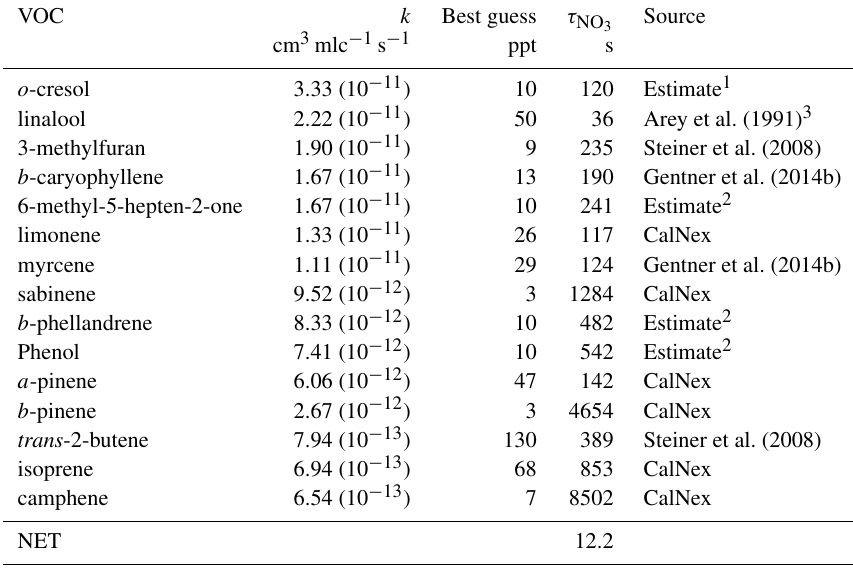
Table 2. Estimations of VOC reactions with nitrate in the summertime nocturnal boundary layer for the SSJV. Reaction rates from Atkinson and Arey (1998), Table 2, and Atkinson et al. (2006). Source VOC k Best guess τ NO 3 cm 3 mlc − 1 s − 1 ppt o -cresol 3.33 (10 − 11 ) 120 Estimate 1 linalool 2.22 (10 − 11 ) Arey et al. (1991) 3